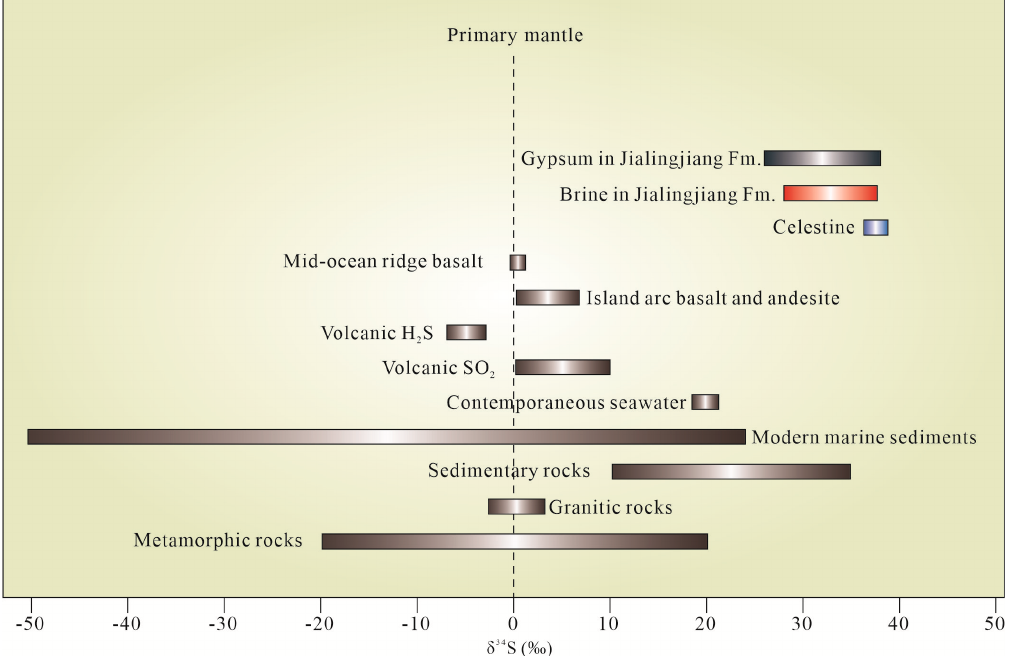
Figure 12. S isotopic compositions of celestine. S isotope data of the gypsum and brine in the Jialingjiang Formation are obtained from [74].